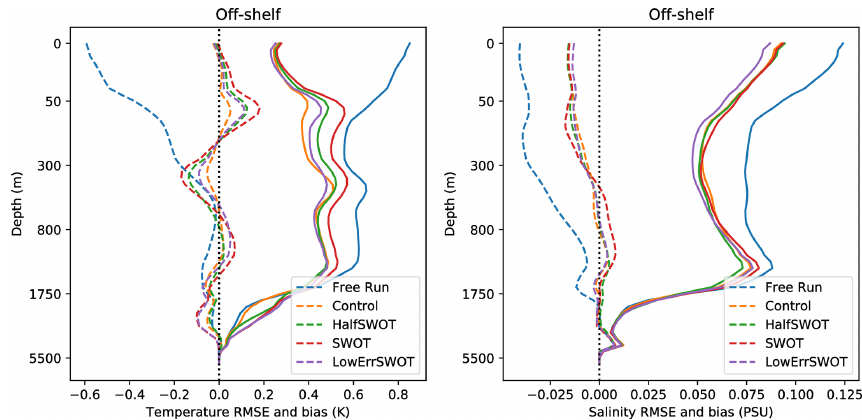
Figure 12. Off-shelf temperature and salinity RMSE (solid) and bias (dashed) averaged over the full year of the experiments. Note the log scale used for depth to highlight the differences in the upper